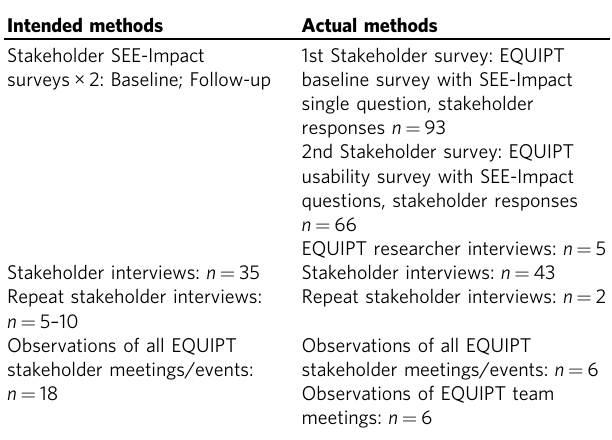
Table 1 Intended and actual SEE-Impact data collection methods.